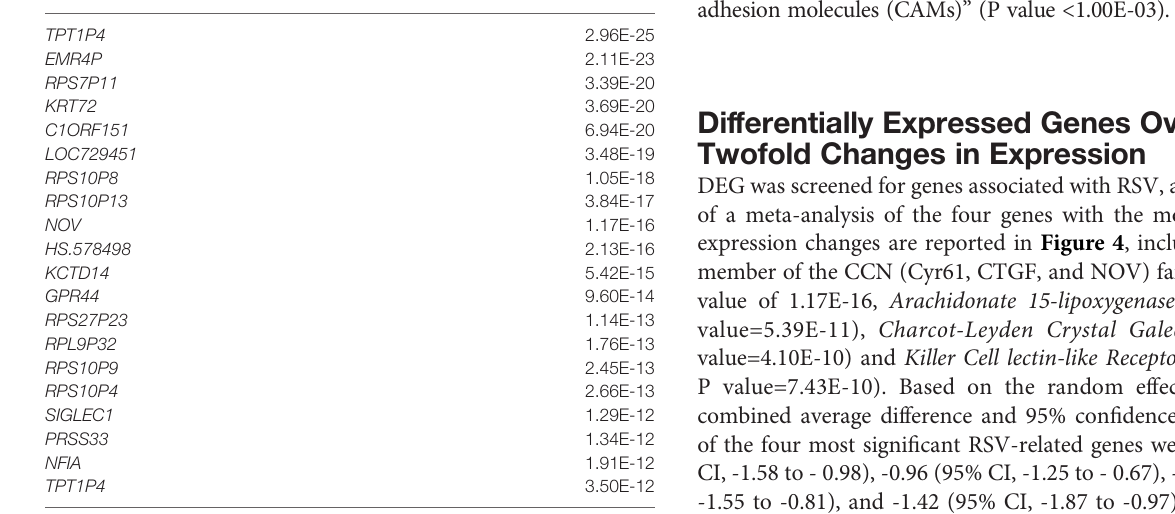
TABLE 2 | The top 20 most signi fi cant DEGs by meta-analysis.